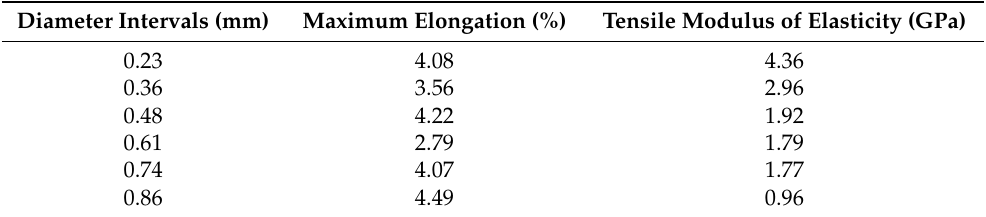
Table 5. Maximum elongation and modulus of elasticity of the sedge of each diameter interval. Diameter Intervals (mm) Maximum Elongation